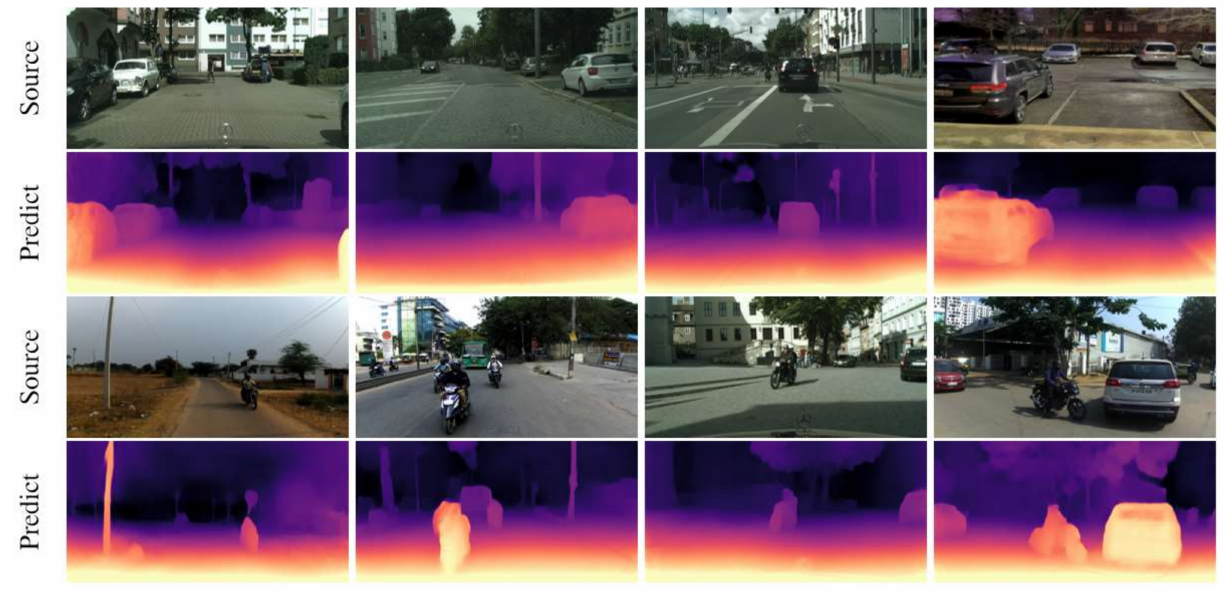
Figure 5. We train our model on KITTI and then test our model by the images from cityscapes, DIODE, IDD. In the first row, the first three pictures are from cityscapes; the fourth picture is from DIODE. The pictures in the second row are from IDD.